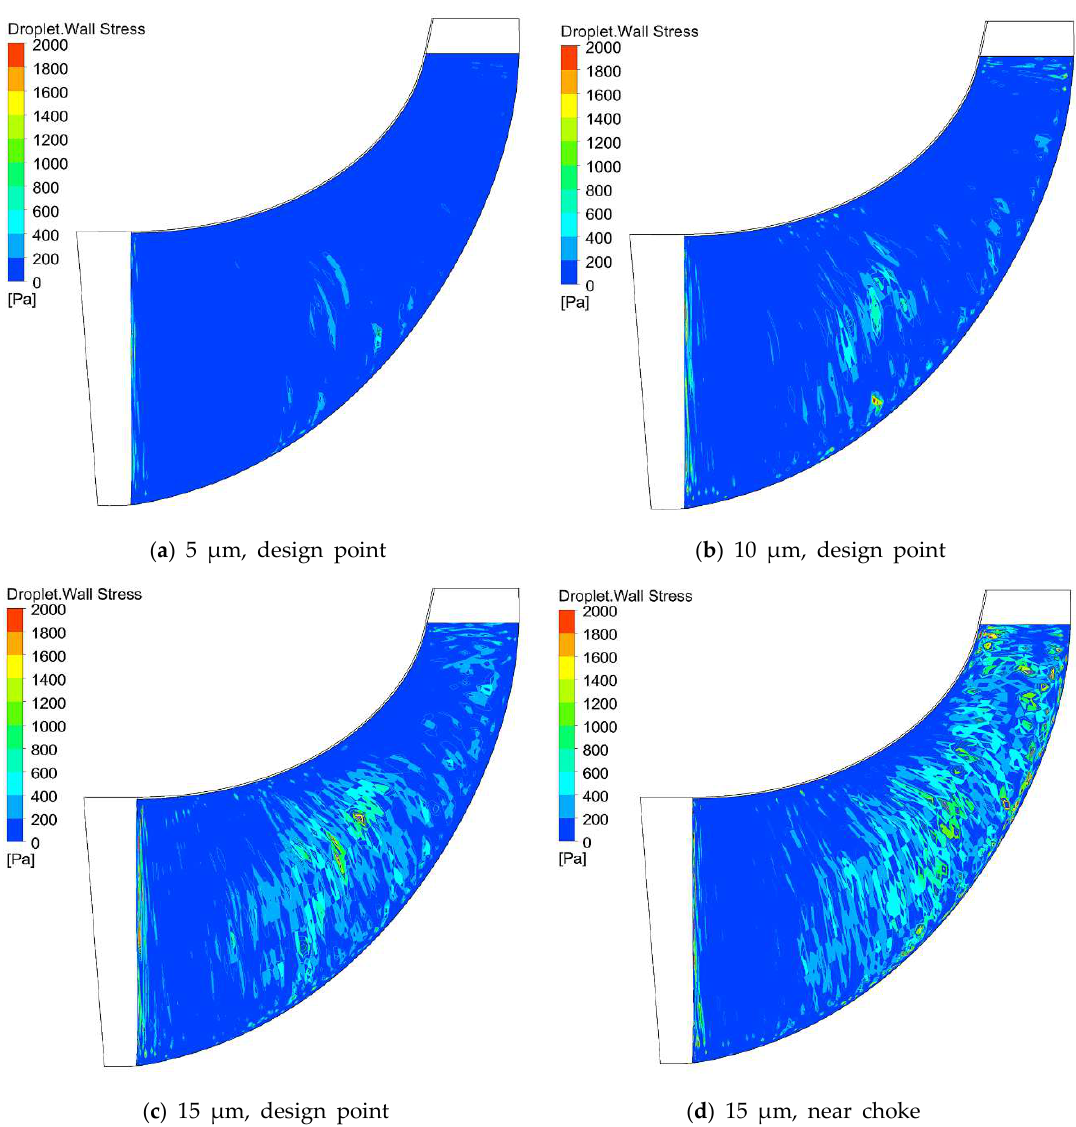
Figure 18. Droplet-wall stress at the impeller pressure side